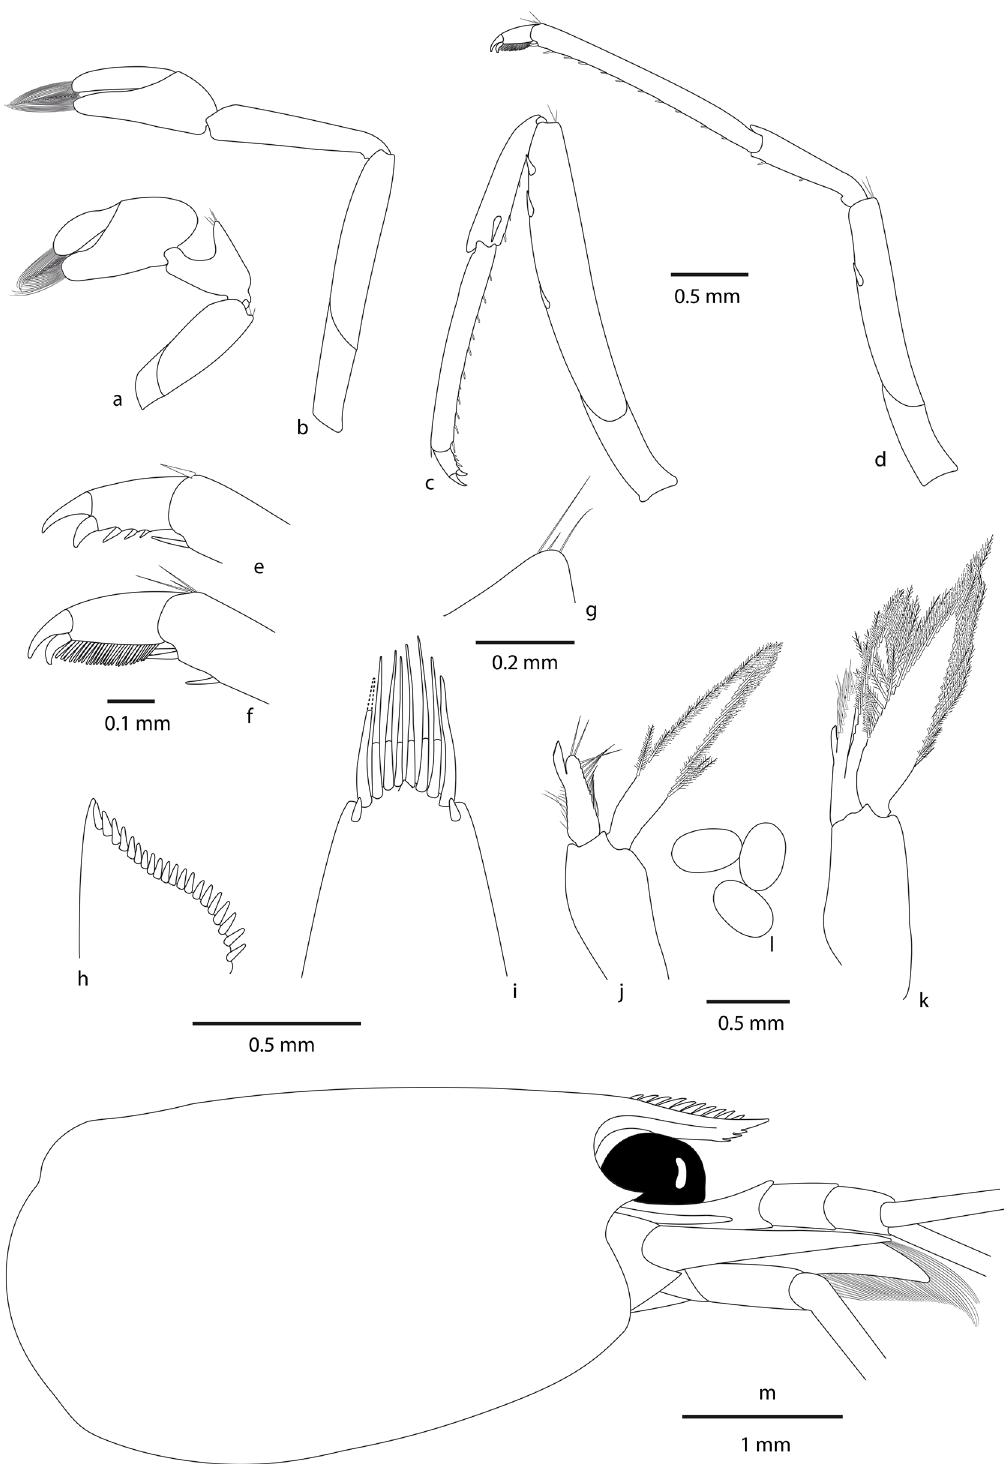
Fig. 14. Caridina papuana Nobili, 1905. a . First pereiopod. b . Second pereiopod. c . Third pereiopod. d . Fifth pereiopod. e . Dactylus of third pereiopod. f . Dactylus of fifth pereiopod. g . Pre-anal carina. h . Uropodal diaeresis. i . Telson. j . First male pleopod. k . Second male pleopod. l . Eggs. m .